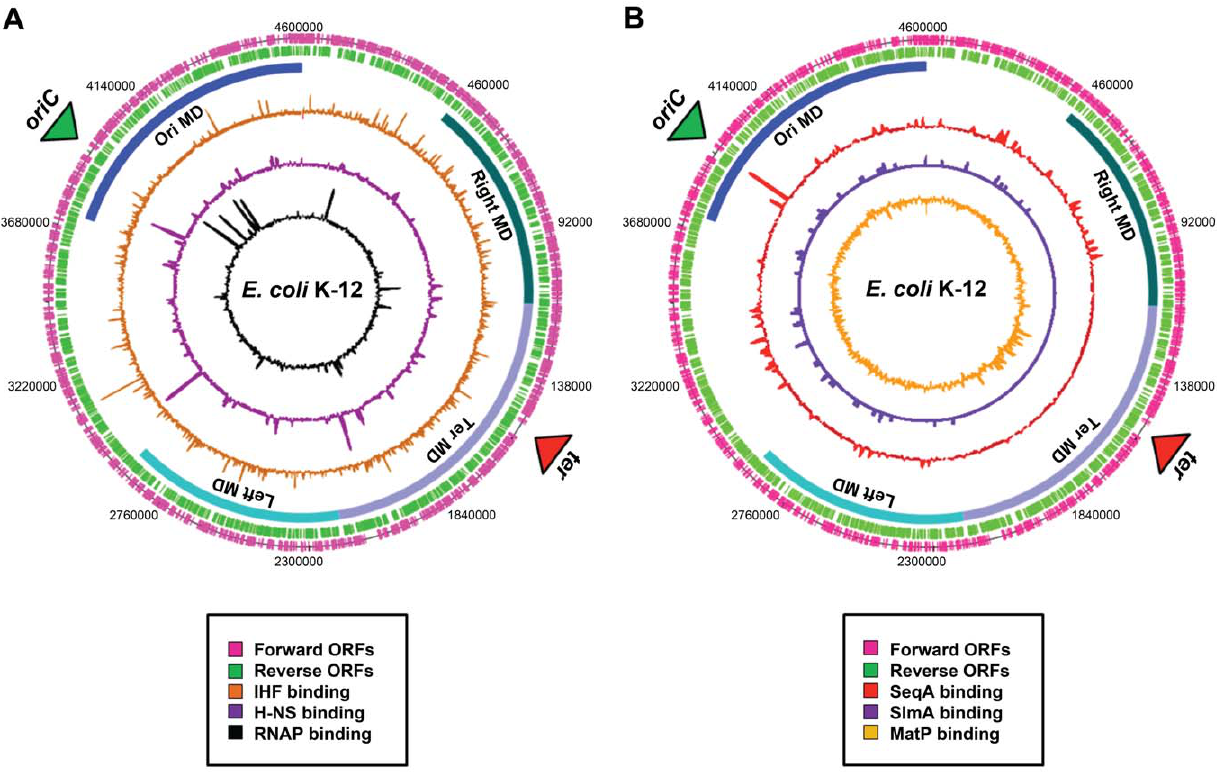
Figure 2. Distribution of nucleoid-associated proteins across the E.coli chromosome. (A) A genome atlas where ChIP-chip datasets [41] for IHF (orange), H-NS (purple), and RNA polymerase (black) are plotted against the features of the E. coli chromosome. (B) A genome atlas where ChIP- chip or ChIP-Seq datasets for SeqA (red) [17], SlmA [purple] (19) and MatP [orange] (20) are plotted against the features of the E. coli chromosome. The locations of ORFs are shown as pink and green lines. The positions of the four macrodomains (MDs) are shown as blue bars and are